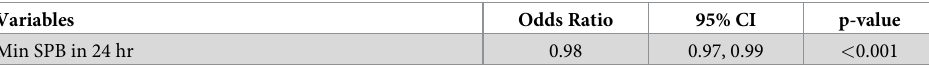
(Table 6). The AUROC for Blacks and Asians are 0.94 (95% CI: 0.82.1.0) and 0.94 (95% CI: 0.90. 0.99), compared to that for Whites 0.82 (95% CI: 0.78, 0.86) (p > 0.05) (Table 6). There is no statistical difference between the model performance in female versus male patients (p > 0.05).